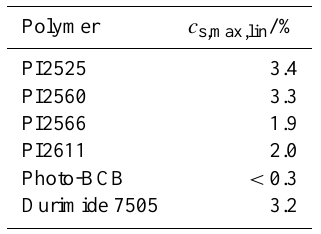
Table 1. Maximum loading capacity of Durimide 7505 and the polymers measured in the reference (Buchhold et al.,